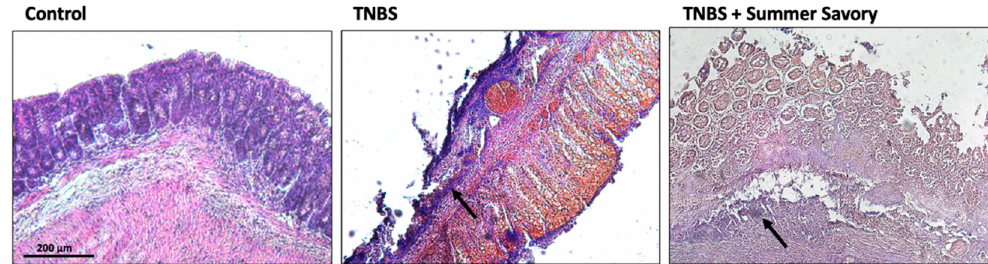
Figure 8. Histological analysis revealed that specimens from TNBS colitis group exhibited very marked ulceration, thin mucosa with destruction of crypts, and severely increased infiltration of neutrophils (score 3, black-arrow), while specimens from animals treated with Summer Savory extract exhibited colon with erosion of the mucosa and small superficial ulcers disseminated across the length of the colon, with crypt loss and slight mononuclear cell infiltration (score 1, black-arrow). Sham Group ( n = 6); EtOH Group ( n = 6); TNBS + EtOH Group ( n = 10); TNBS + Summer Savory Group ( n = 10). Original magnification ×100. Scale bar equals 200 µm.